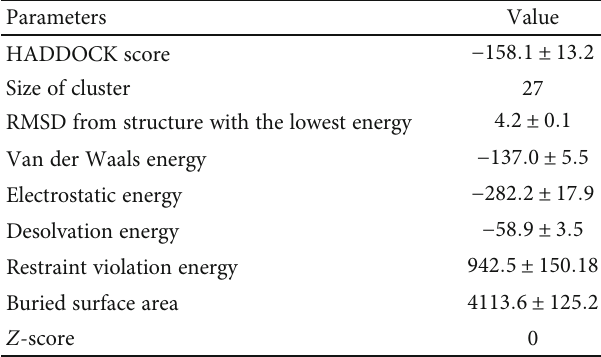
Table 3: Statistics of the highest-scored vaccine-TLR3 docked cluster. A negative value of the HADDOCK score projects good protein-protein interaction potential.